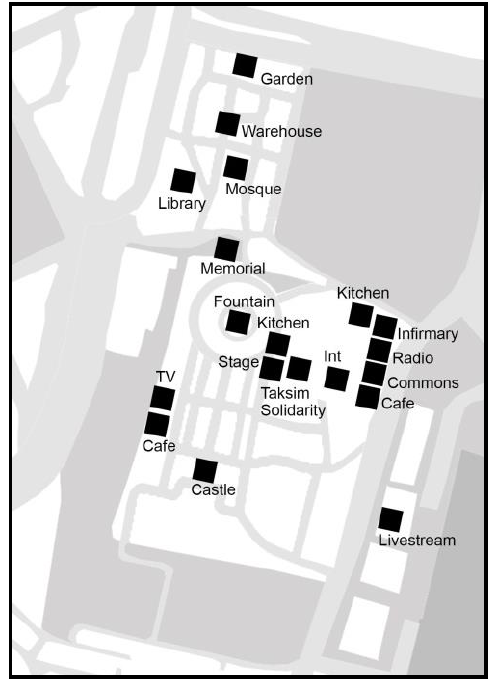
Figure 8. Facilities inside Gezi Commune, map reproduced by the authors from Istanbul Greater Municipality’s City Map (Istanbul Greater Municipality, n.d.) and sketches in Historical Atlas of Gezi Park